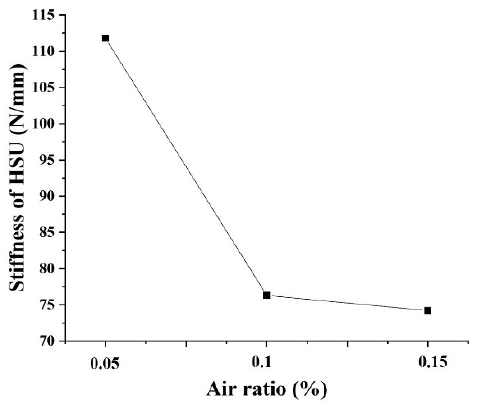
Figure 10. Curve of the stiffness of the HSU versus the air ratio.